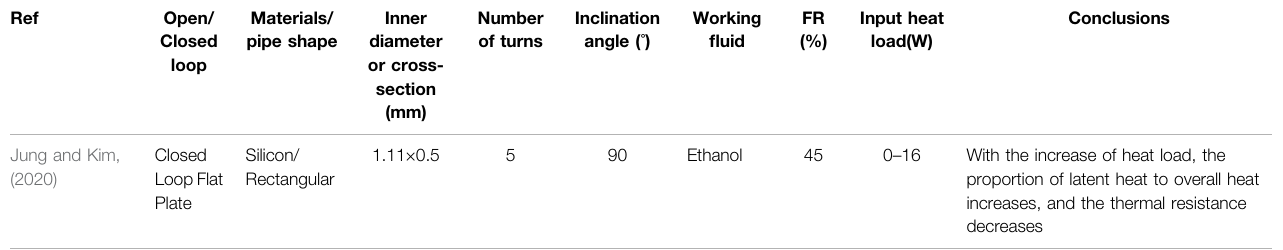
TABLE 2 | ( Continued ) Summary of experimental investigations on factors affecting the performance of PHPs.